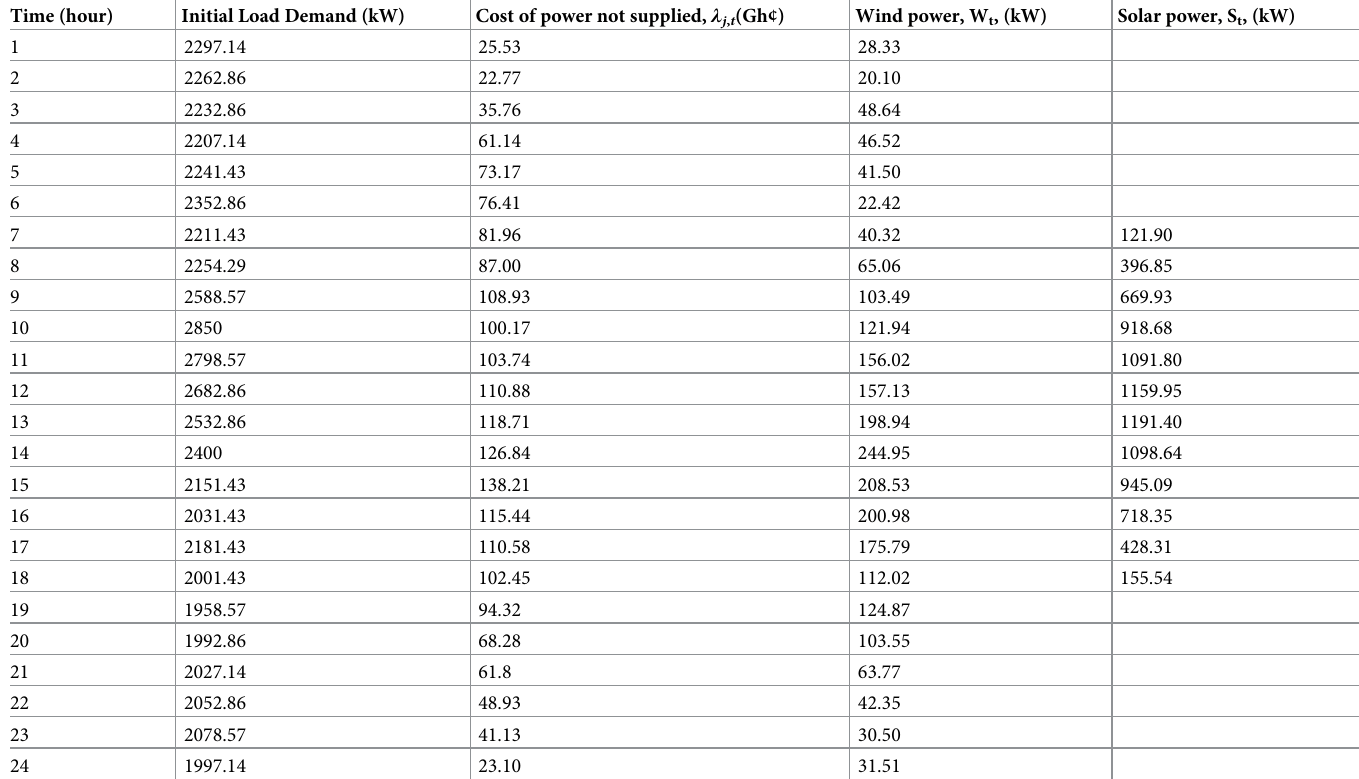
Table 5. Hourly load demand, cost of not supplying power to a consumer, wind power and solar power–case 2. Time (hour) Initial Load Demand (kW)